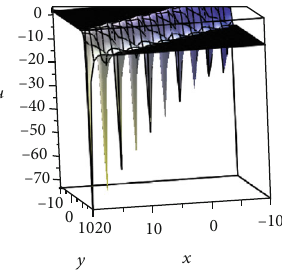
Figure 6: Spatiotemporal structure of solution (22) with the parameter selections a 2 = 1 , a 5 = 1 , a 7 = 1 , k 1 = 1 , k 2 = 1 , δ 1 = 1 , = 1 , and δ = 1 δ 5 6